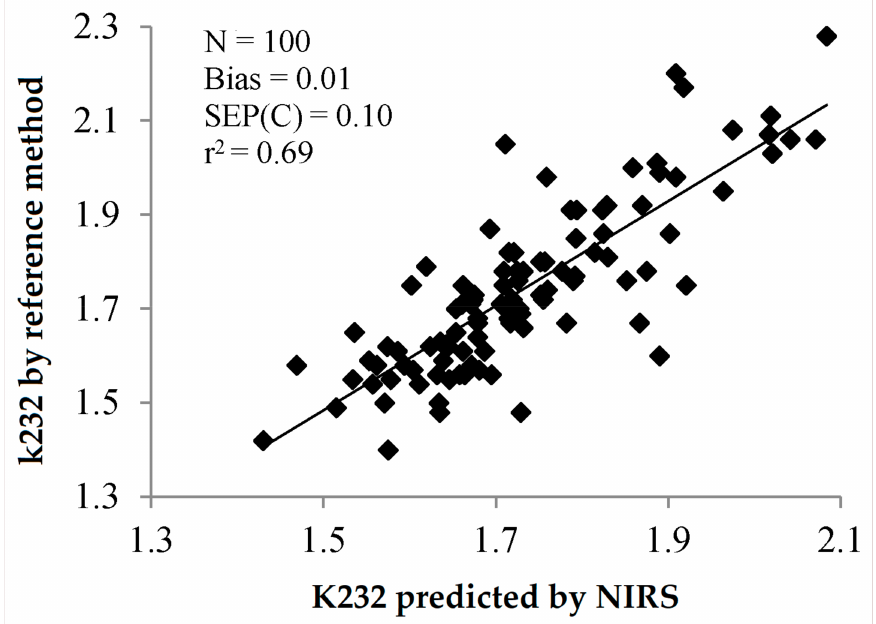
Figure 11. Validation exercise for the determination of K232 of olive oil by PLS-NIRS using all the wavelengths between 400 and 2500 nm [30].